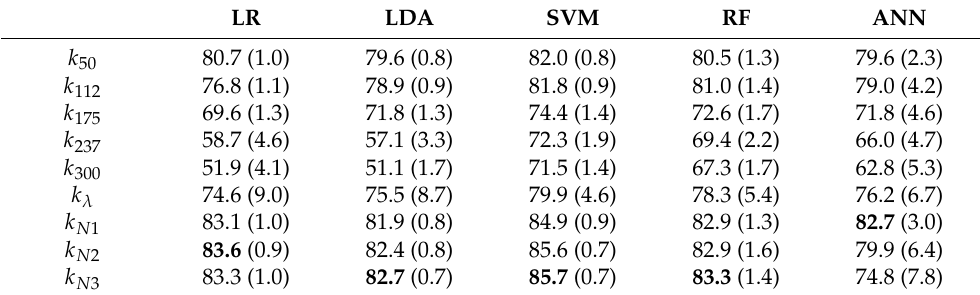
Table 5. Total accuracy (and standard deviation) in % of the classification using five different classifiers depending on the scales evaluated in n p = 2000 samples in B = 100 repetitions. The values were calculated by averaging the total accuracy in each repetition. The numbers in bold represent maximum values.